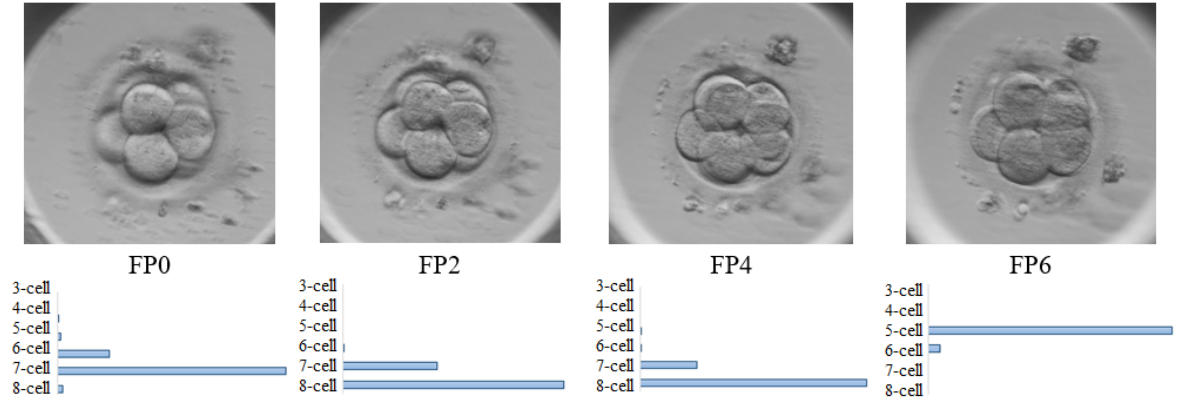
Figure 1. Examples of 8-cell embryo captured in FP0, FP2, FP4 and FP6 focal